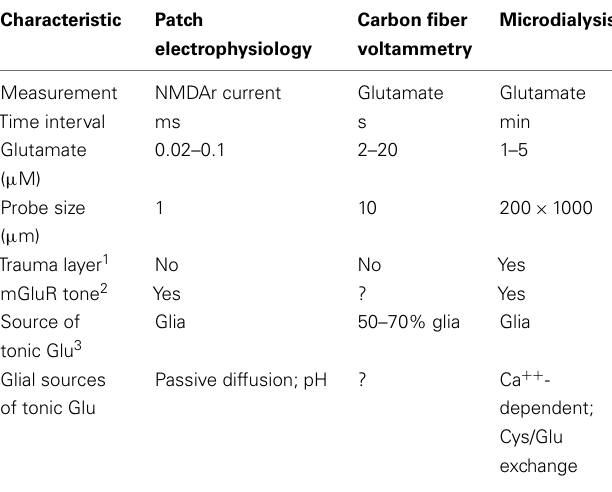
Table 1 | Characteristics of tonic extracellular glutamate measured using different